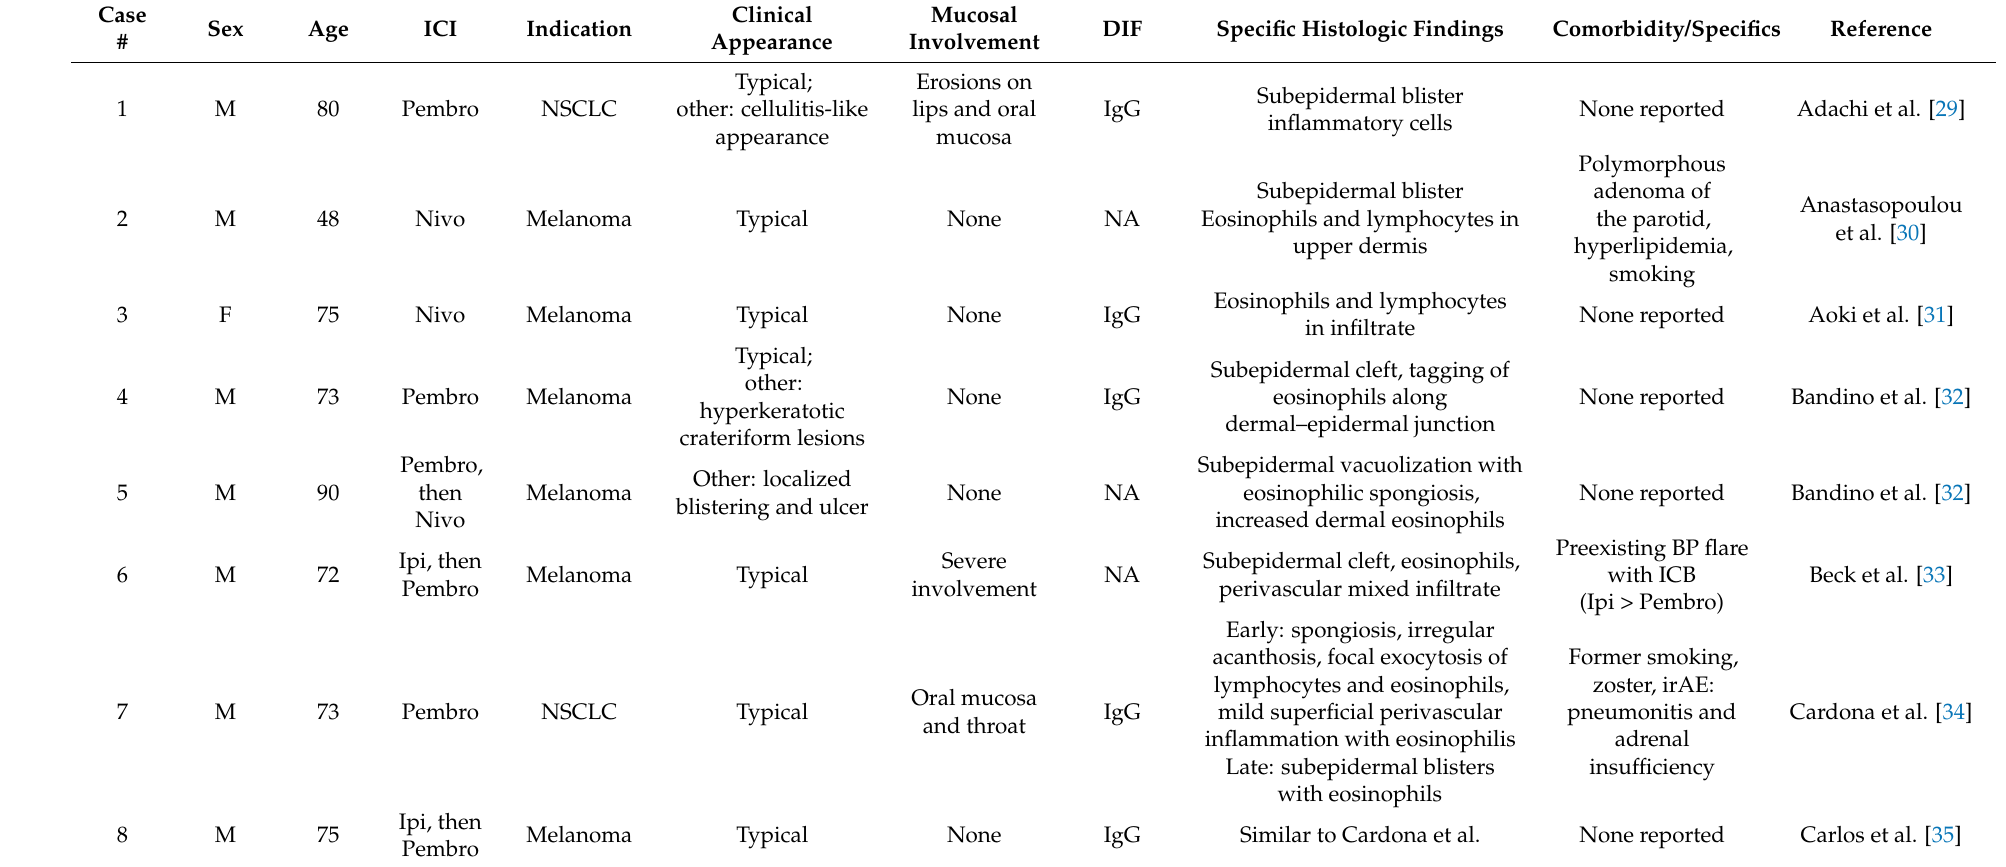
Table 2. Overview of case reports of BP and lichen planus pemphigoides (LPP) in patients receiving ICB with a focus on clinical and histopathological findings (alphabetical order of first authors, as of May 2021). Cases involving both programmed cell death protein 1/ligand 1 inhibitors (PD1/PDL1) and cytotoxic T-lymphocyte associated protein 4 (CTLA4) inhibitors were included. The manuscripts were manually scanned for relevant comorbidity and specific information with regard to BP (e.g., diabetes type II); tumor-related symptoms are not listed (e.g., renal failure in association with urothelial cancer), whereas concomitant side effects of ICB are